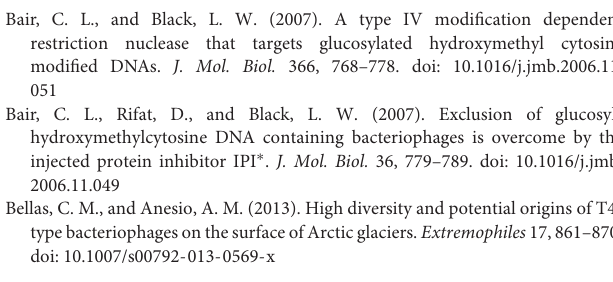
Supplementary Figure 1 | Heat map representations of a number of homologous clusters in separate genomes. Horizontal lines represent genomes of viruses, vertical lines are homologous clusters.